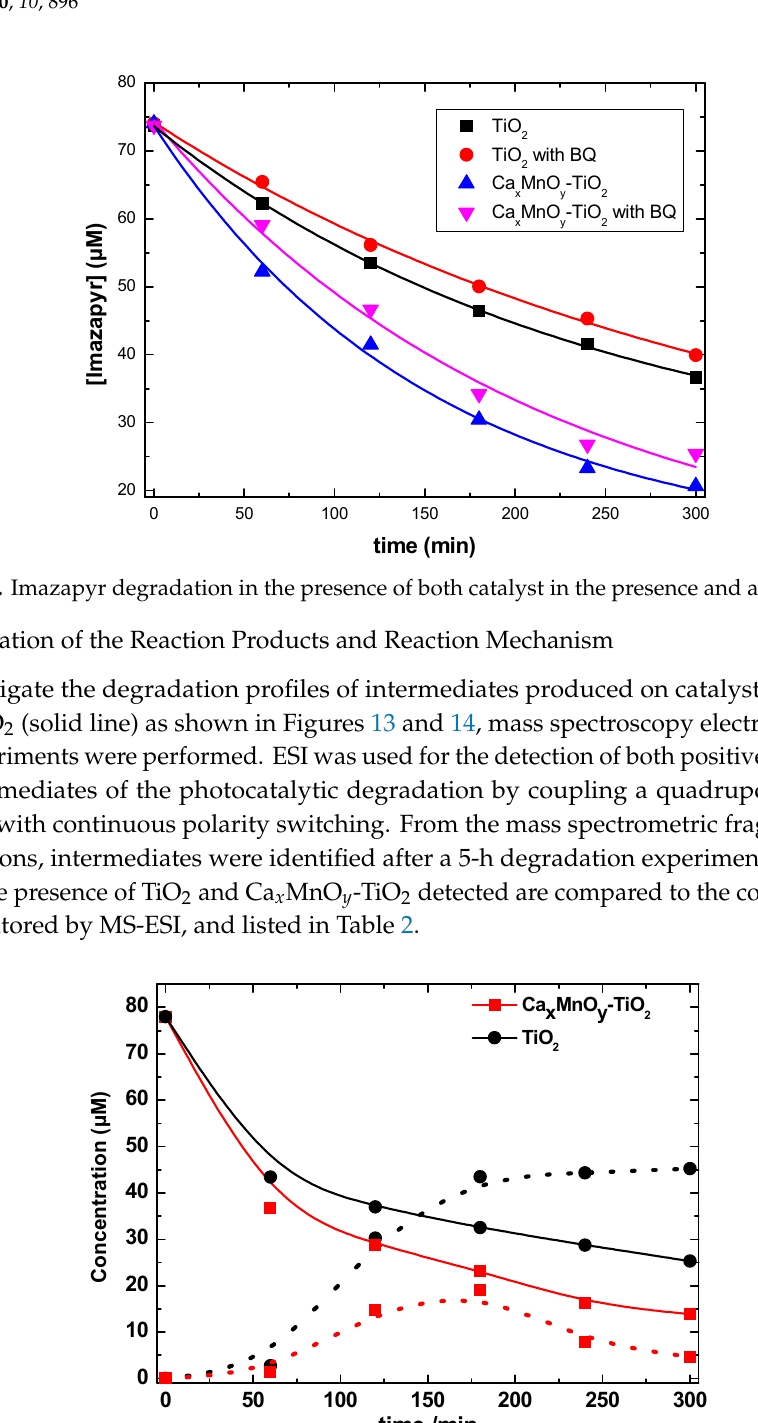
Figure 14. Change in concentration vs. time for various intermediates (represented by their corresponding m/z) of the photocatalytic Imazapyr degradation, determined by the MS-ESI.